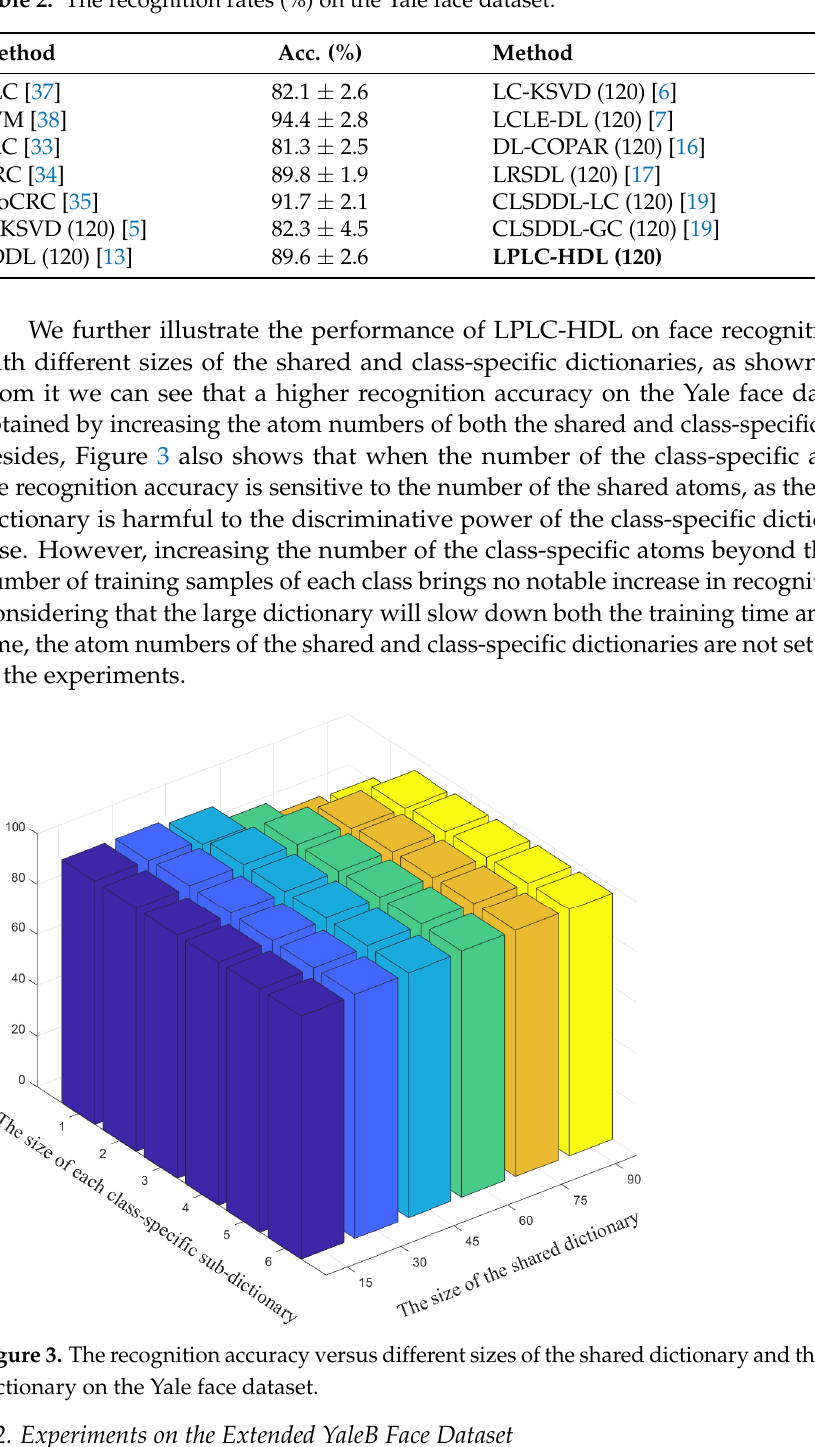
Table 2. The recognition rates (%) on the Yale face dataset.